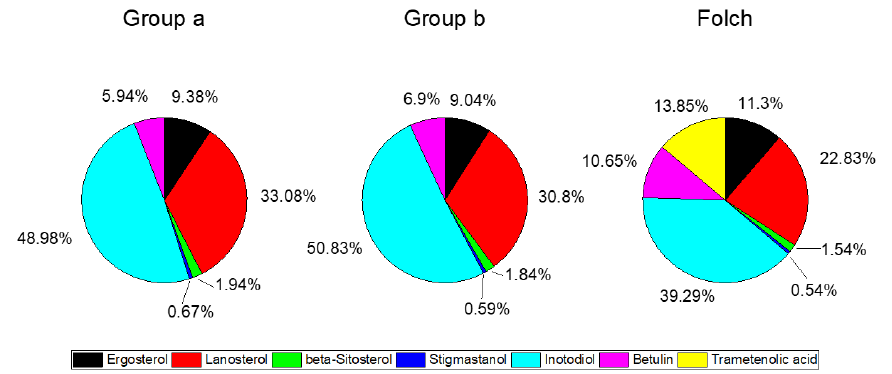
Figure 2. Relative compositional profile of the obtained triterpenoids of SFE and Folch extracts. SFE extracts are averaged and grouped according to the compact letter display of the total triterpenoid (mg/100 g Chaga) amounts reported in Table 1.